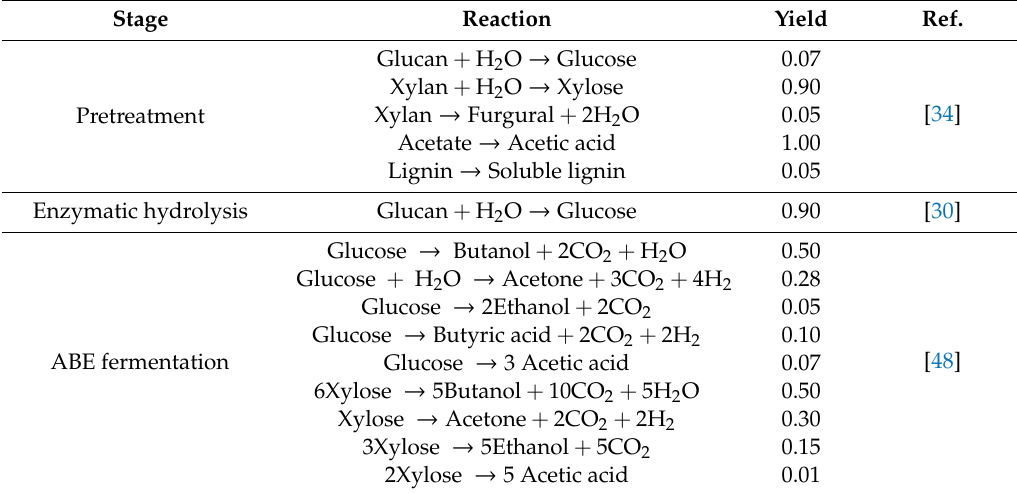
Table 2. Summary of the stoichiometric equations for topology 1.